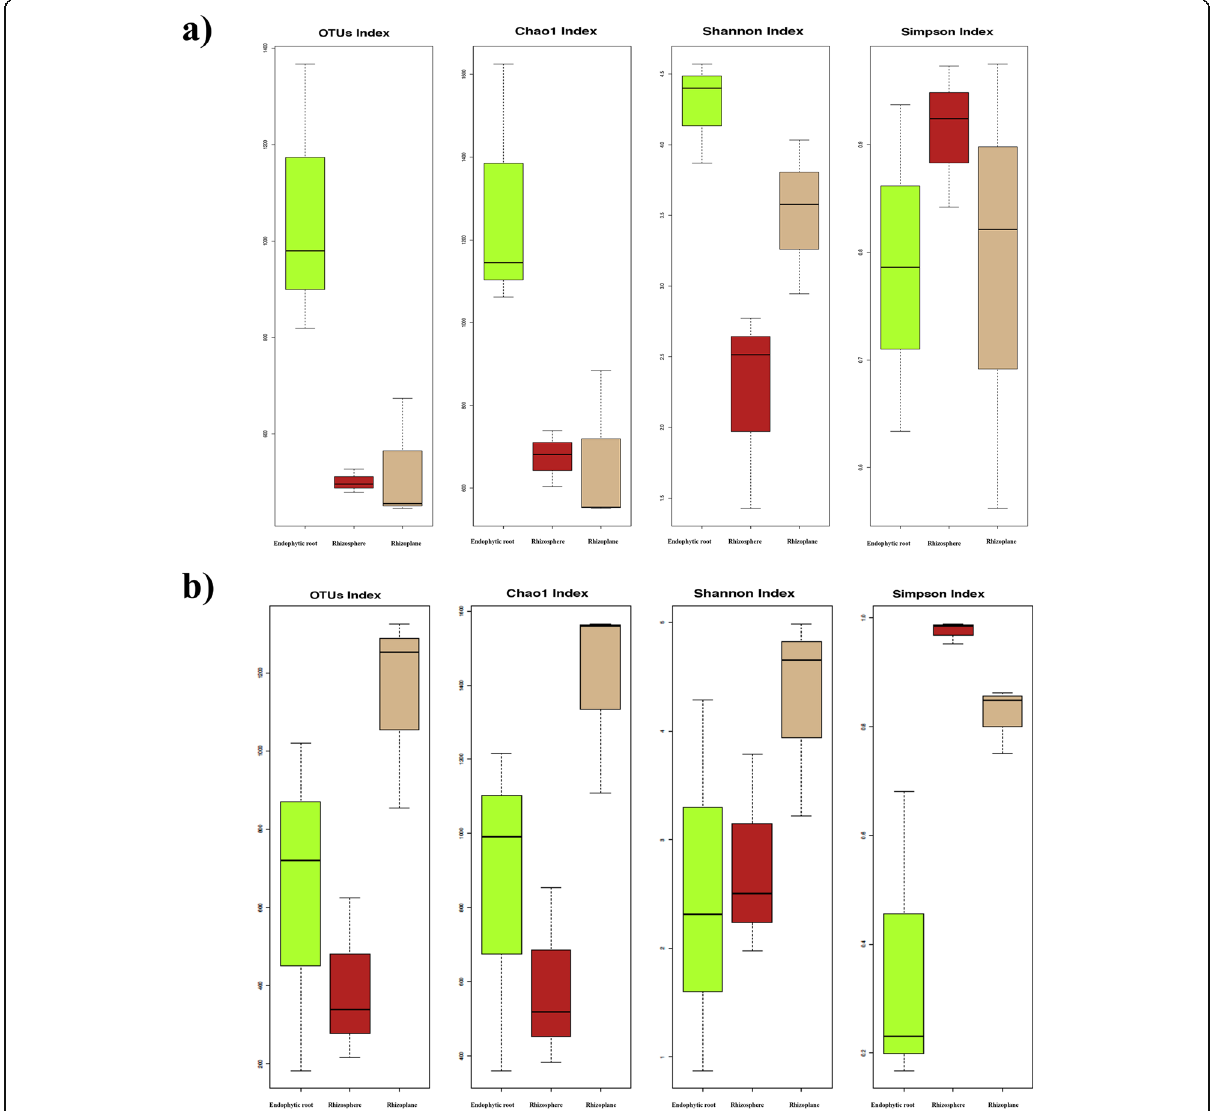
Fig. 1 Alpha-diversity index of bacterial communities across the different samples of a C. annuum and b S. lycopersicum